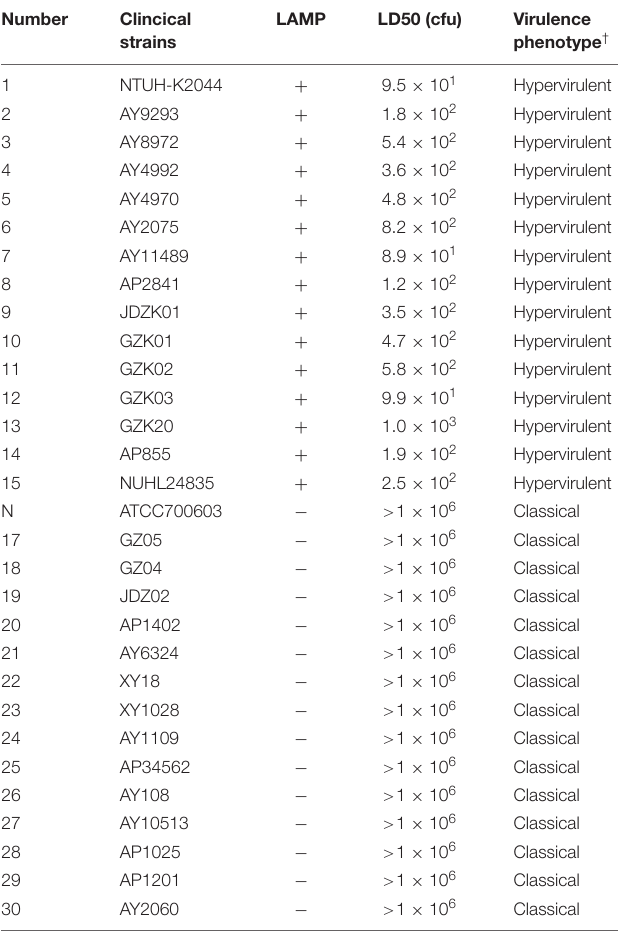
TABLE 3 | Direct detection of peg-344 by LAMP in clinical